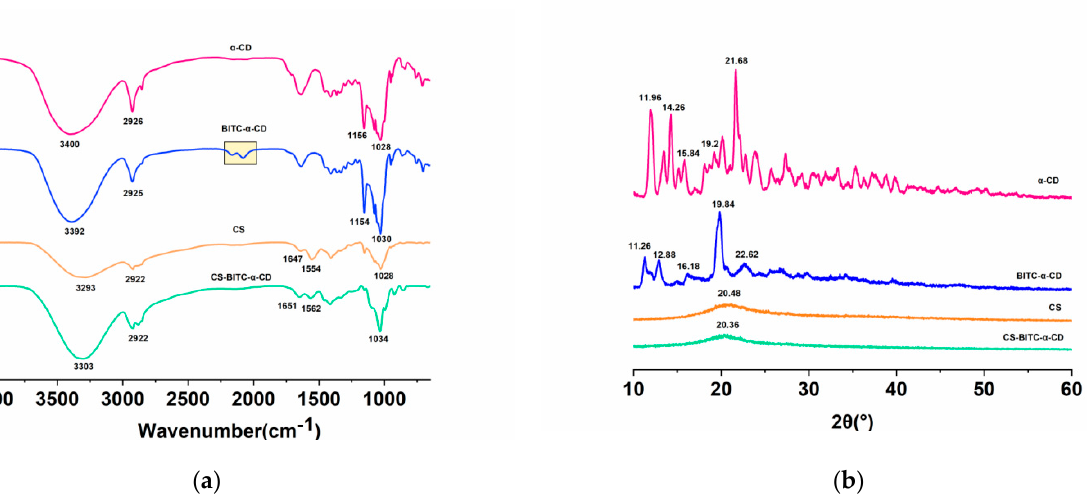
Figure 2. Characterization of inclusion complex and CS − based composite film. ( a ) FTIR spectra of α -CD, BITC −α− CD, CS, and CS − BITC −α− CD; ( b ) XRD patterns of α− CD, BITC −α− CD, CS, and α -CD, BITC − α − CD, CS, and CS − BITC − α − CD; ( b ) XRD patterns of α − CD, BITC − α − CD, CS, and CS − BITC −α− CD. CS − BITC − α −